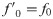
Online adaptation of the channel statistics for a biased channel.A decoder with k = 8, β = 8 is used for selection. In each panel, the decoder is initially run with f′0=f0 and f′1=f1 (both randomly chosen in the range [0.0, 0.35]). At symbol 100, f0 and f1 are changed to random values, and f′0 and f′1 are automatically adapted using Eq 16.